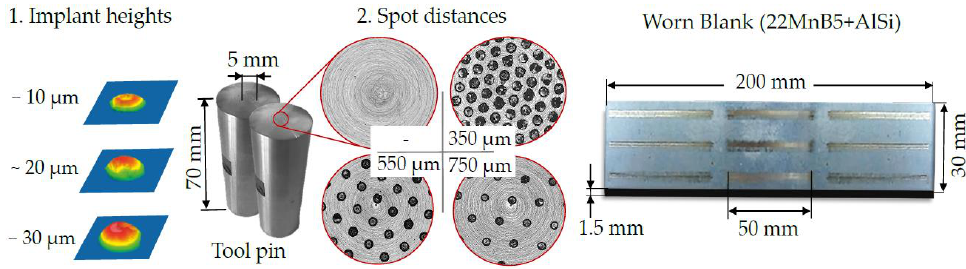
Figure 3. Tool configurations and worn blank topography.